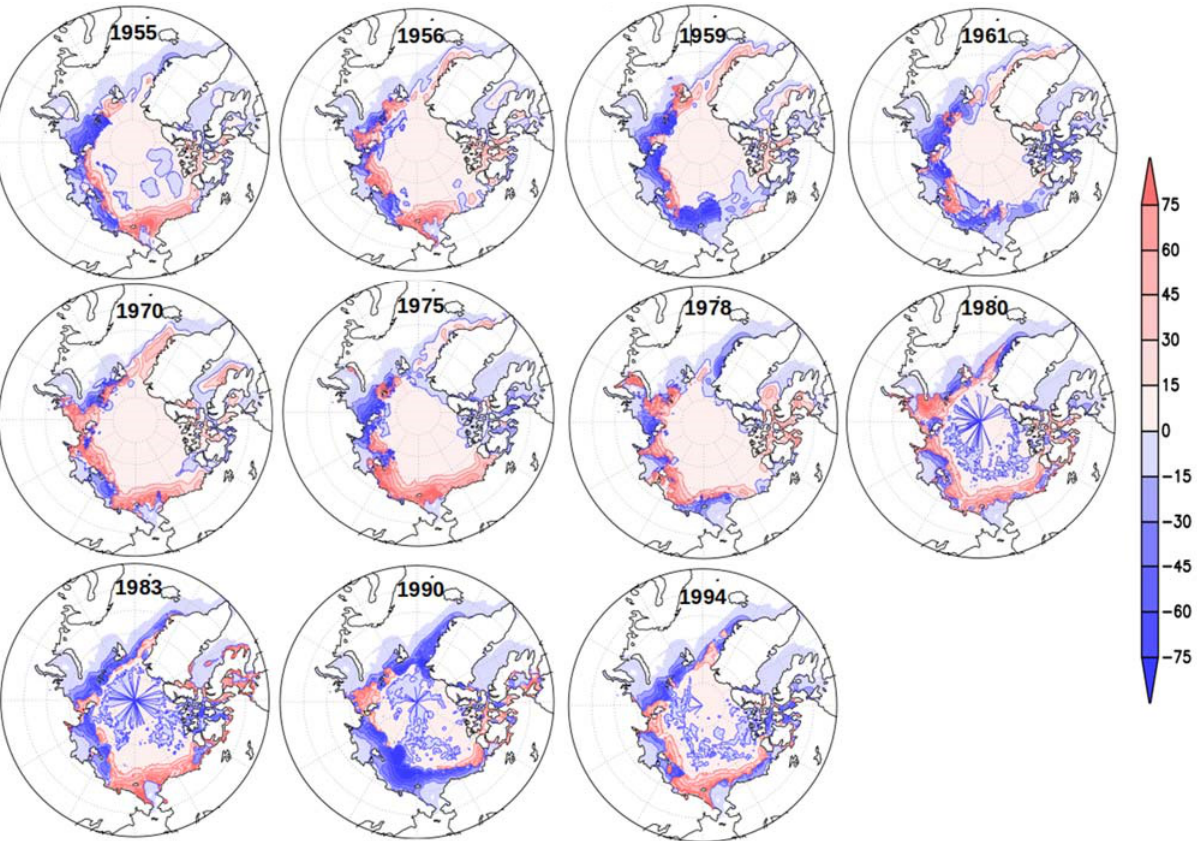
Figure 2. September Arctic sea ice concentration (%) anomalies during strong ISM years. Climatology is over the period 1951–2000.